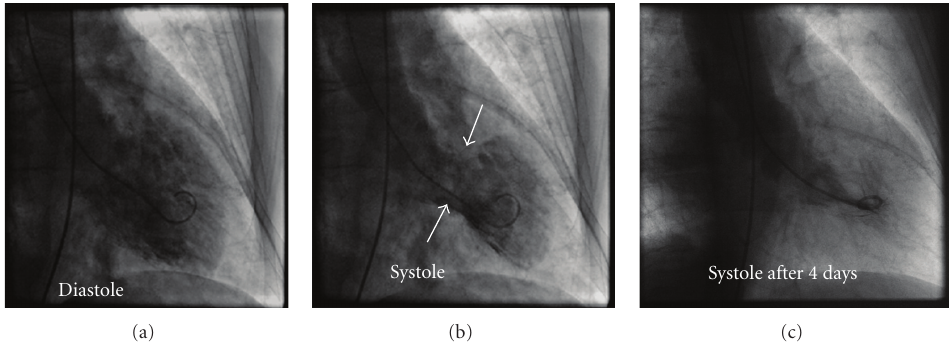
Figure 3: LV angiogram in diastole (a) and systole (b) in right anterior oblique projection demonstrating wall-motion abnormality characteristic of stress cardiomyopathy. At end systole, LV chamber adopts distinctive “short neck with round flask” configuration in which distal (apical) portion is akinetic/hypokinetic, whereas in contrast, the remaining proximal (basal) segment is hypercontractile. Left panel, angiogram after 4 days.